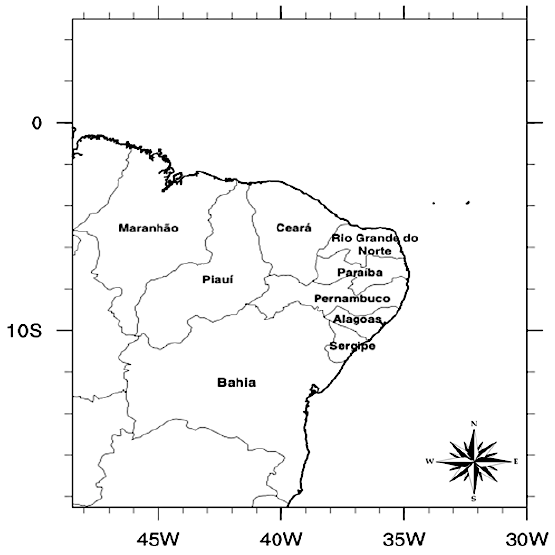
Figure 1. Northeastern Brazil and atmospheric aerosol inflow region. Scale 1 : 300 000.